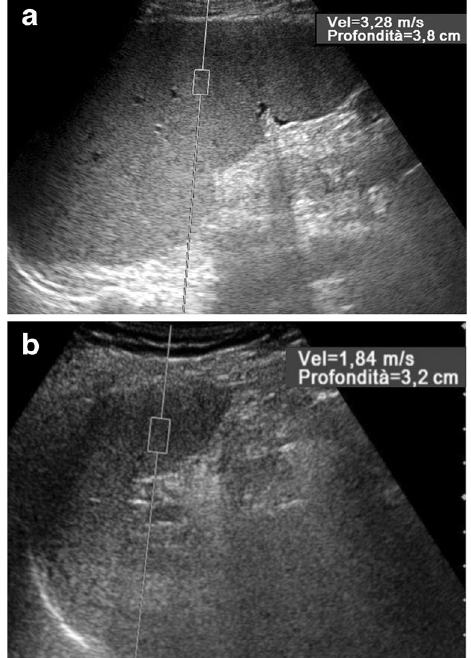
Fig. 11 ARFI evaluation of the spleen in patients with alcoholic liver cirrhosis. Longitudinal US scans. The SWV value is lower (1.84 vs. 3.28 m/s) in a 54-year-old man with Child-Pugh score A ( a ) than in a 51-year-old man with Child-Pugh score C ( b ), with severe portal hypertension and recurrent variceal